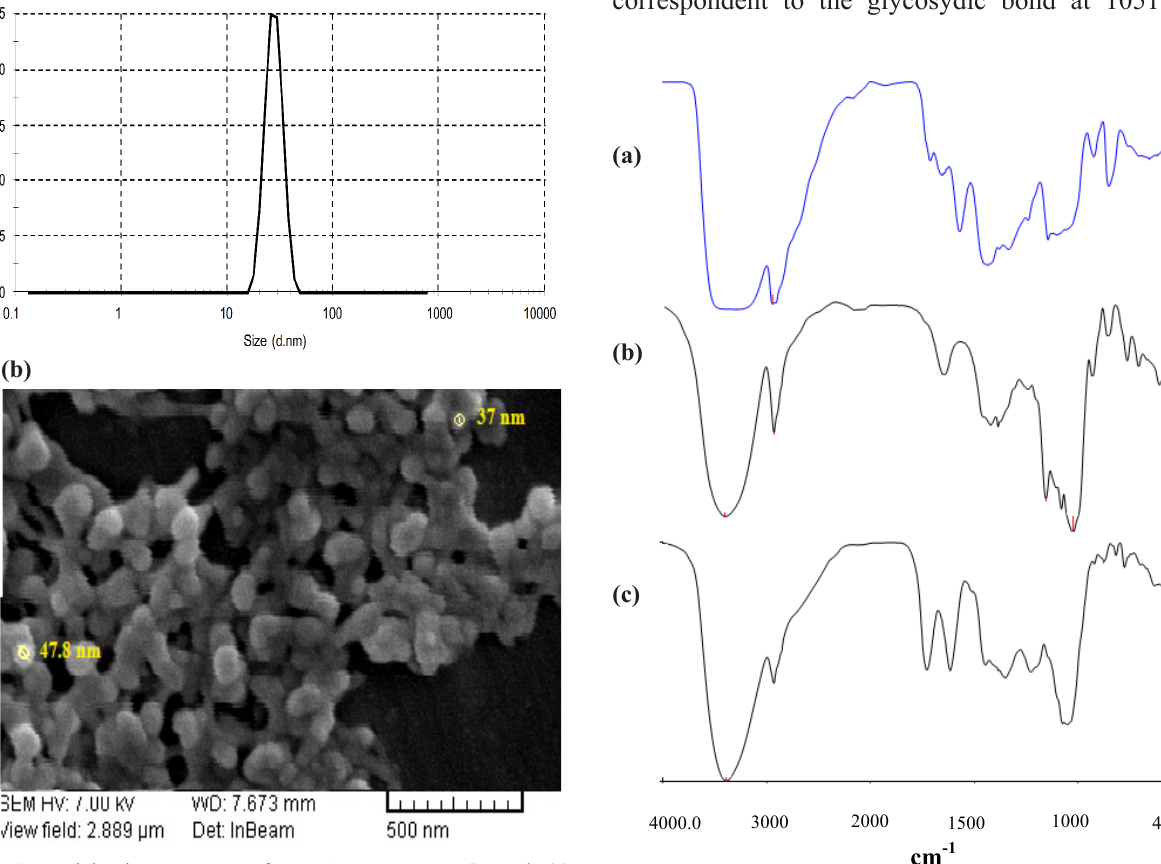
Fig. 3. Particle size spectrum of MD-APPE NPs, DLS result (a), FE-SEM image (b). Fig. 4. FT-IR spectra of MD-APPE NPs (a), MD (b) and APPE